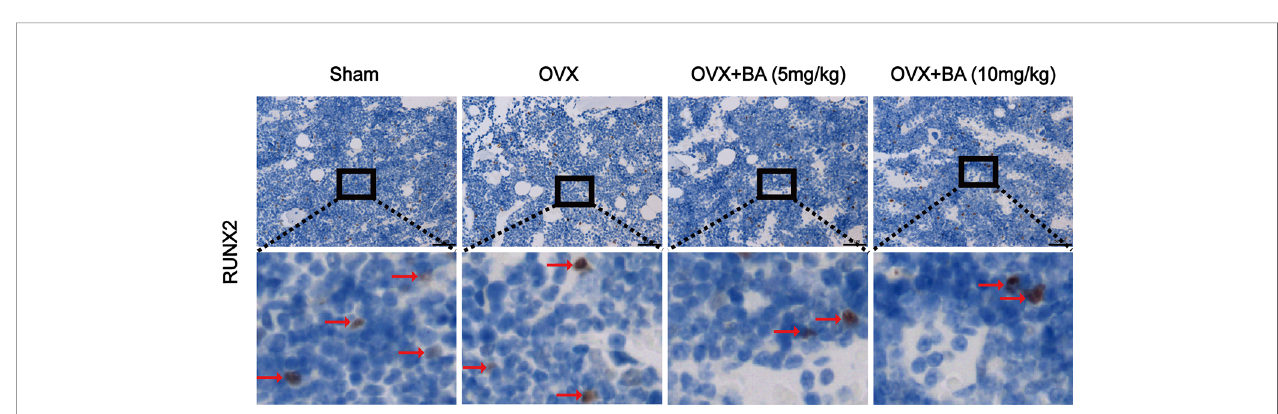
FIGURE 6 | BA does not affect ovariectomized (OVX)-induced expression of RUNX2 ex vivo . The expression of RUNX2 protein in tibial tissues in each group was detected by immunohistochemistry, and the expression of RUNX2 in the images were brown or russet and indicated by the red arrow. RUNX2, runt-related transcription factor 2.